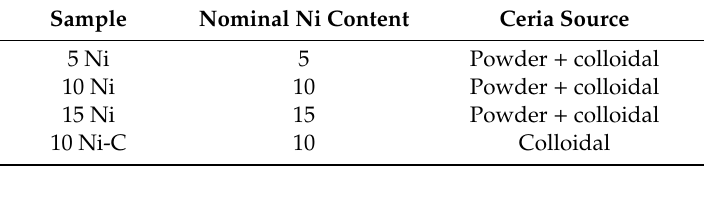
Table 1. Samples labels, nominal Ni contents (wt %), and ceria source for the prepared structured catalysts.